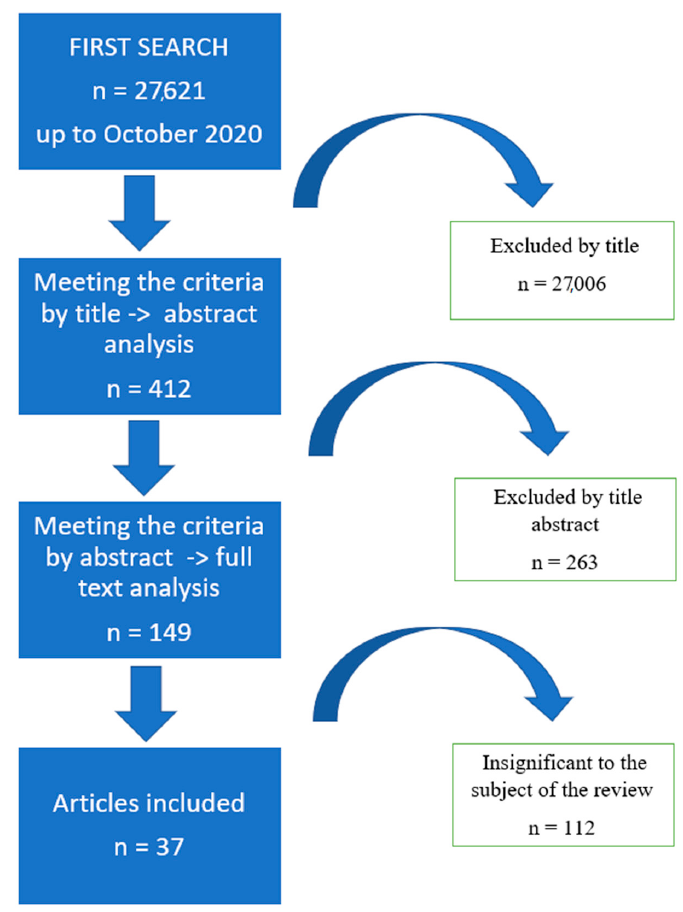
Figure 1. Flow chart of research methodology.